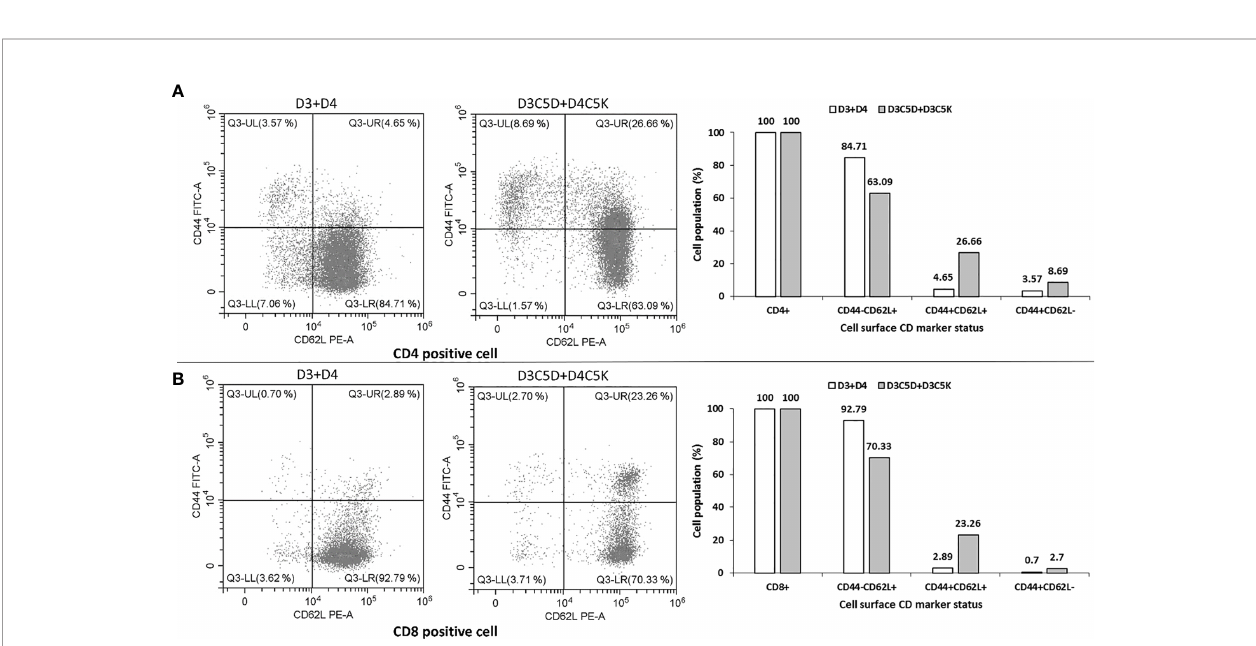
FIGURE 5 | Immune response against ED3 variants. IgG titers of (A) D3ED3, D3C5D, D3C5K and D3C5D+D3C5K and (B) D4ED3, D4C5D, D4C5K and D4C5D+D4C5K after the 5 th dose measured using the tail-bleed sera of mice. D3ED3 and D4ED3 proteins were used as coating antigens for (A, B) , respectively. All mice are shown in the fi gure, and the total number of mice ( n ) used for immunization with the untagged and single charged ED3 mutants was n =3; D3C5D+D3C5K/ D4C5D+D4C5K, n =5; D3C5D+D4C5K, n =5, and D3+D4, n =3. The average IgG titer (grey bars) was calculated using data from three highest responsive mice (closed circles), and excluding the low and non-responsive/non-bivalent ones (open circle). Antibody titers of D3+D4 and D3C5D+D4C5K (after the 5 th dose) when the plates were coated with (C) D3ED3 and (D) D4ED3. Long term IgG titers of D3C5D+D4C5K and D3+D4 against the coating antigens (E) D3ED3 and (F) D4ED3. “ TB ” indicates the number of tail-bleeding experiment counting from the fi rst tail-bleeding after the 1 st injection. A booster dose was given two days after TB-12. The IgG titer of TB-13 indicates the immune response a week after the booster dose was administrated. Doses were formulated at a fi nal protein concentration of 0.3 mg/ml in PBS or PB. Line symbols are explained within the panels.